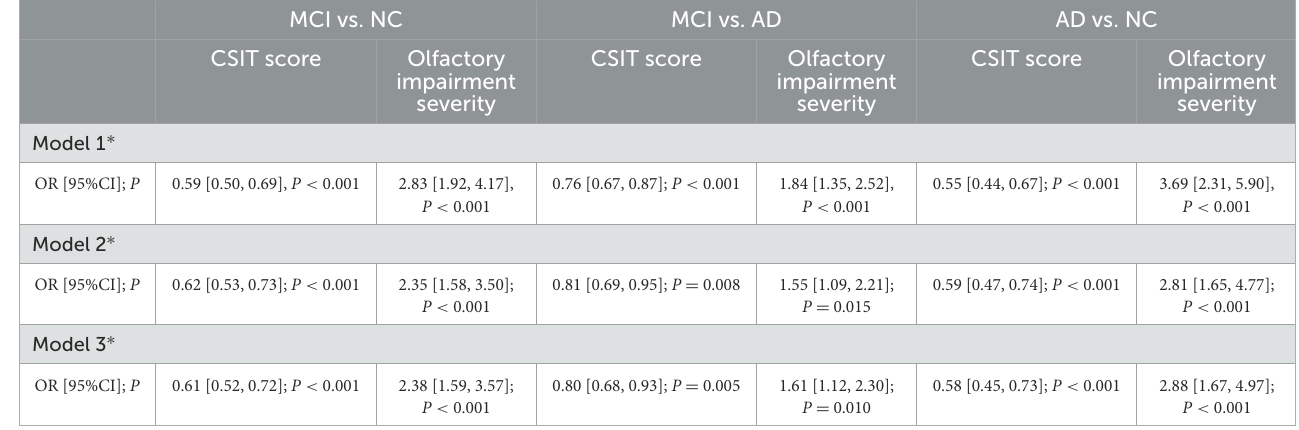
TABLE 4 Logistic analysis of the association between the CSIT score and olfactory impairment severity with the risk of MCI and AD.